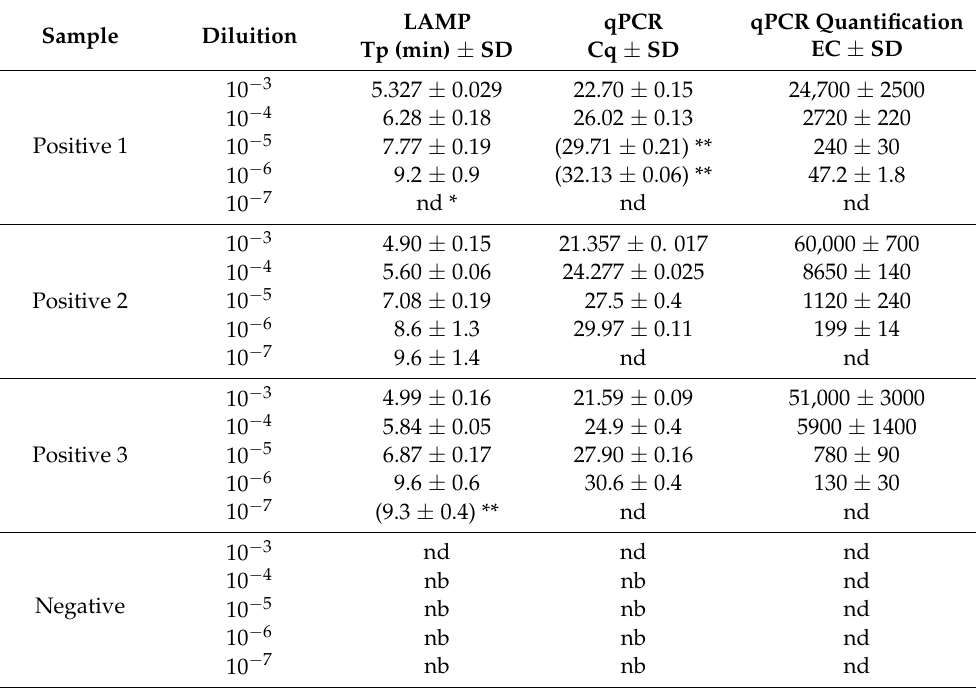
Table 5. Comparison between LAMP and real-time PCR on serial dilutions of cDNA from three wheat plants mechanically inoculated with SBCMV. Experiment performed in the CFX instrument. Rt: reaction time; Cq: threshold cycle; EC: estimated copy number; SD: standard deviation; nd: not